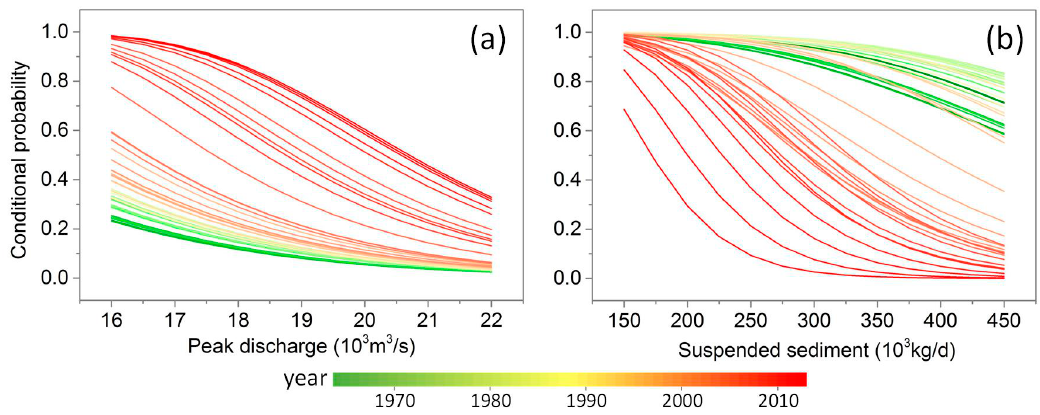
Figure 7. Time variation of conditional probability P Q | Z ( a ) and P S | Z ( b ) with the given warning water stage ( Z ≥ 23.5 m) at the Waizhou station from 1964 to 2013.